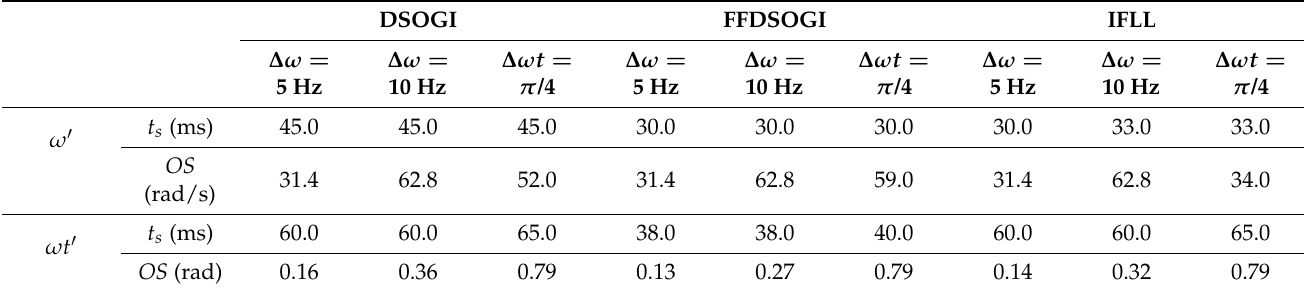
Table 8. Results summary obtained for test #2—overshoot ( OS ) and settling time ( t s ).